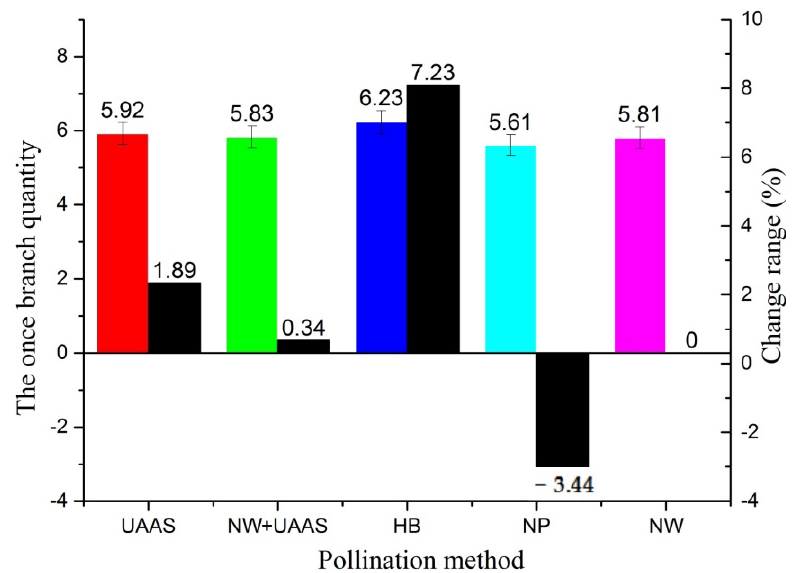
Figure 7. The AOBQs of different pollination areas and AOBQ change ranges. Note: UAAS—unmanned agricultural aerial system; NW+UAAS—natural wind + UAAS; HB—honeybee; NP—no pollinators; NW—natural wind; AOBQ—average once branch quantity.